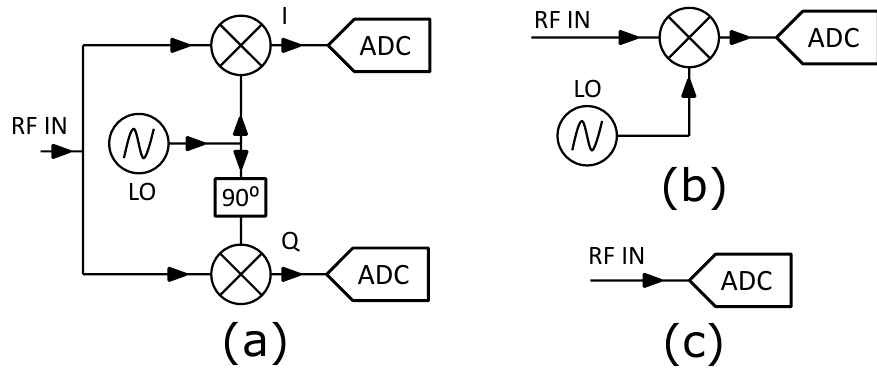
Figure 2. Block diagrams of typical IQ detection schemes: ( a ) analogue IQ demodulation via a quadrature demodulator; ( b ) digital IQ demodulation with analogue downconversion; ( c ) digital IQ demodulation with direct sampling.